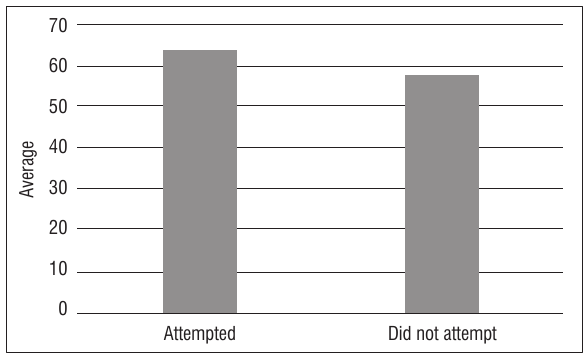
Figure 4: Average exam percentages for Math130 students who attempted and completed the quiz and those who did not.